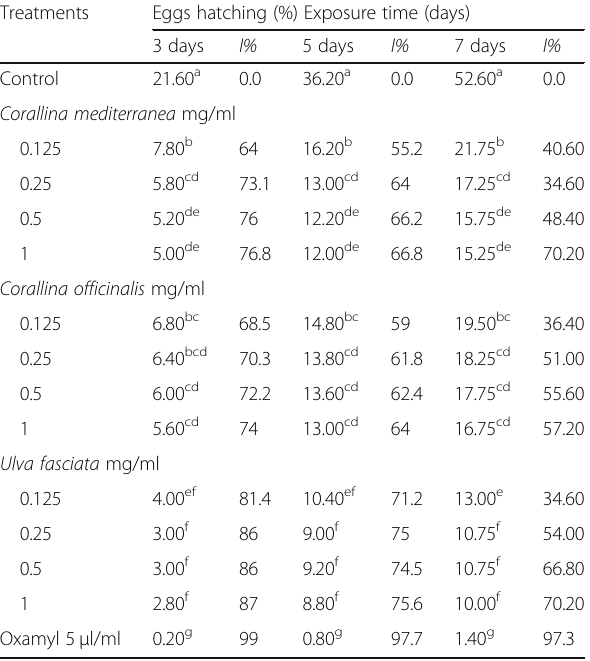
Table 1 Effect of three marine algal extracts on egg hatchability and inhibition percentages (I%) of the root-knot nematode, Meloidogyne incognita under laboratory conditions